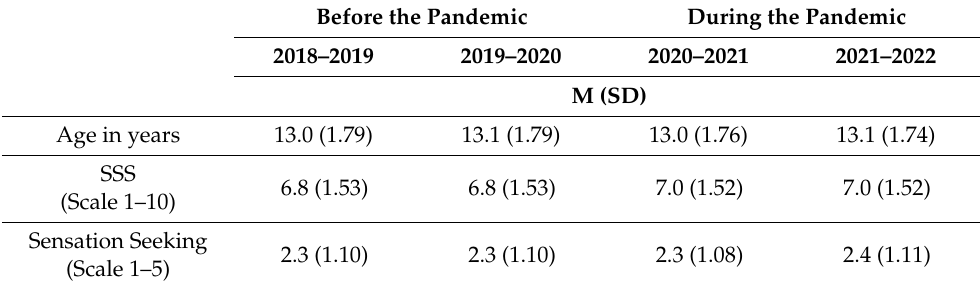
Table 1. Cont. Before the Pandemic During the